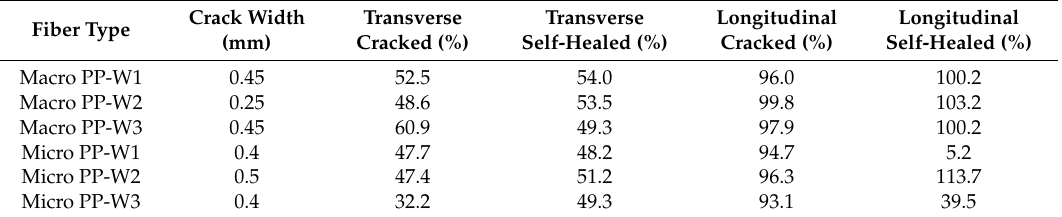
normalized to the original